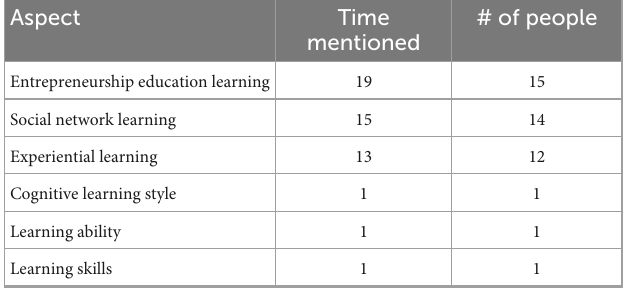
TABLE 1 Factors for participating in EI.